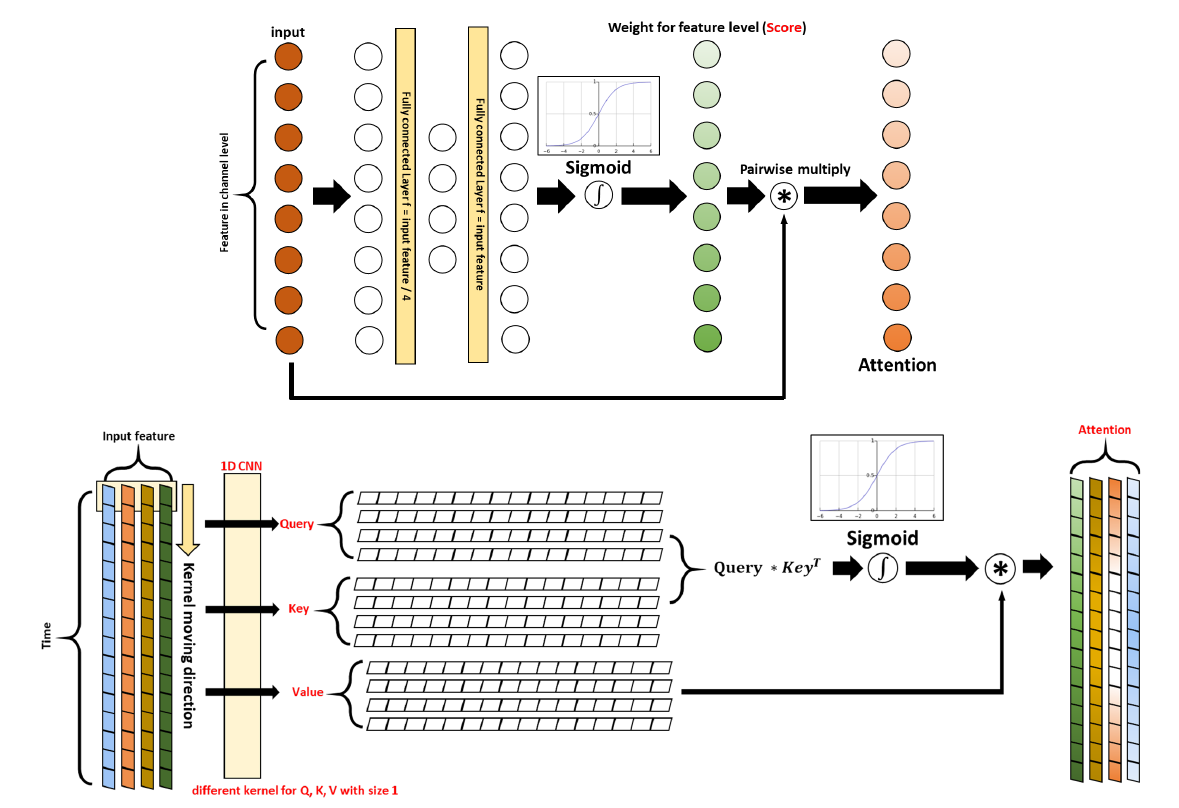
Figure 3. Designed CBAM ( up ) channel level and ( down ) spatial level.